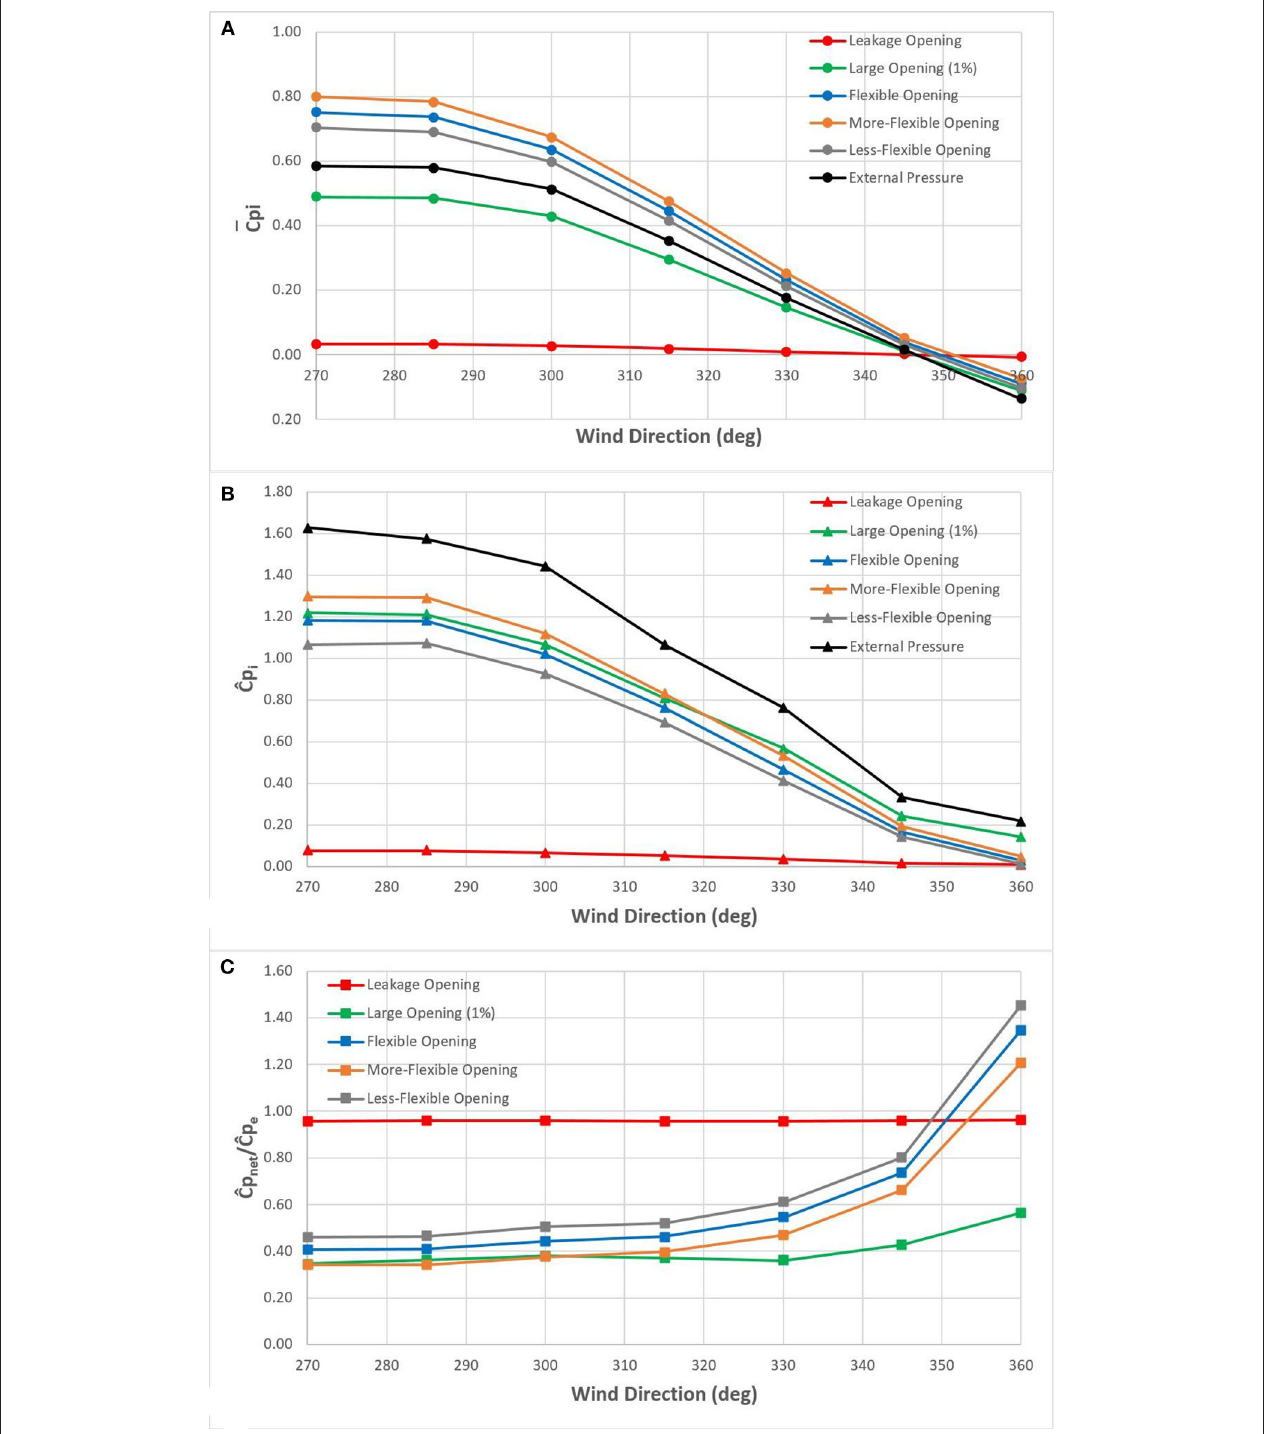
FIGURE 13 | (A) Mean external and internal pressure coefficients, (B) maximum external and internal pressure coefficients, and (C) ratio of maximum net pressure coefficient to maximum external pressure coefficient as a function of wind direction.